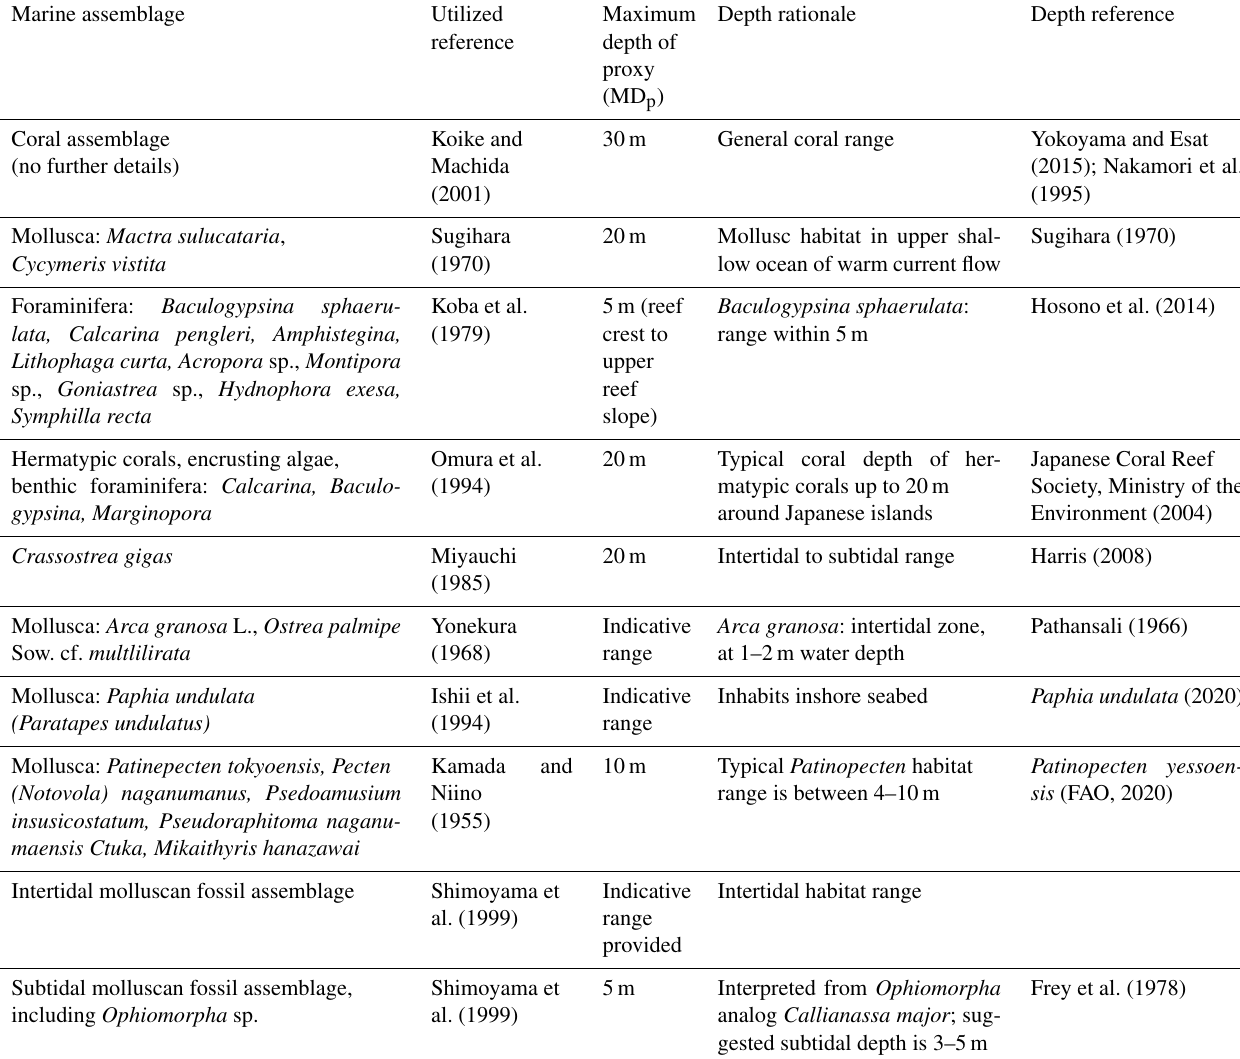
Table 3. Coral assemblage descriptions from reviewed literature used to constrain sea-level margin of error. Marine